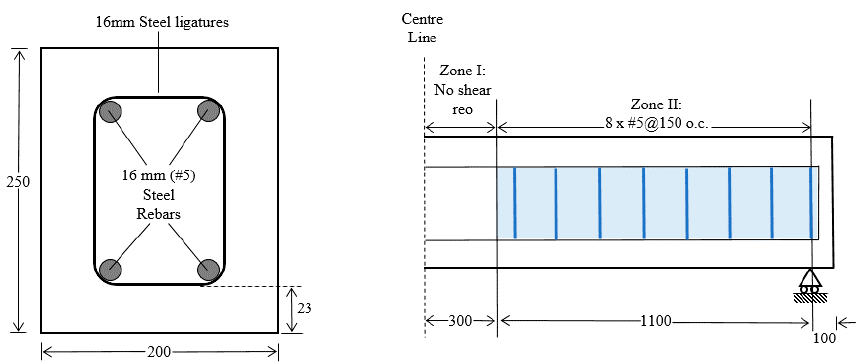
Figure 2. Reinforcement details of BCF1 and BCF2 (all the dimensions are in mm).